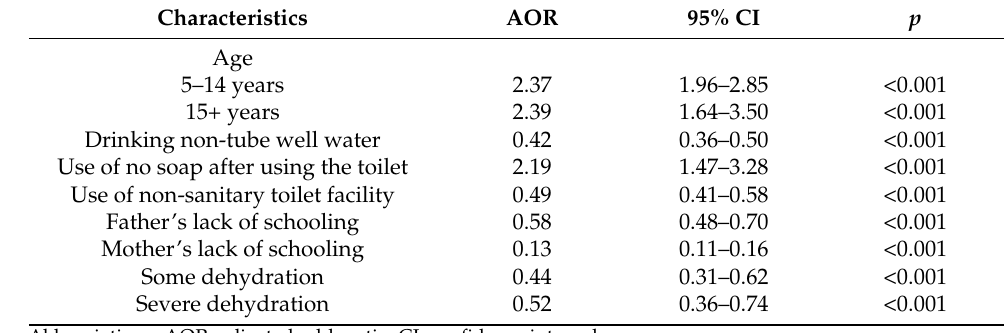
Abbreviations: AOR, adjusted odds ratio; CI, confidence interval.